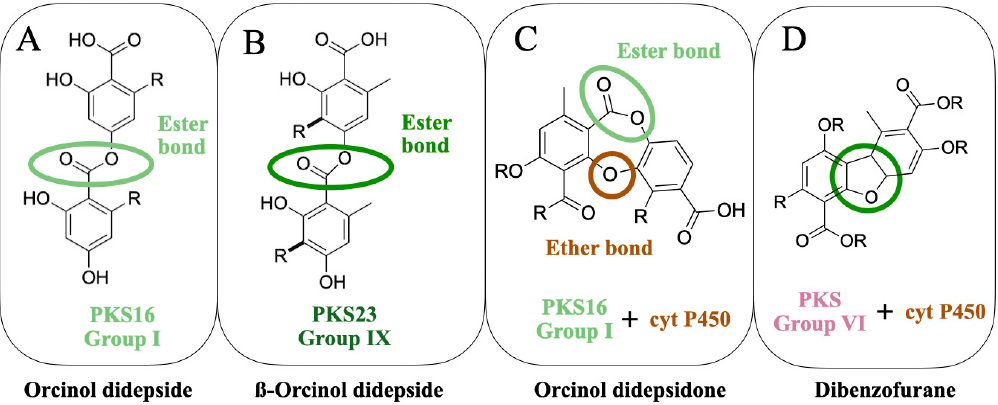
Figure 2. The molecular structures of four classes of lichen compounds linked to the genes. The colored circles denote the characteristic bond of a compound-ester bond present in a depside ( A ), the ester bond of a ß-orcinol depside ( B ), the ester and ether bond present in a depsidone ( C ), and the characteristic dibenzofurane bond ( D ).